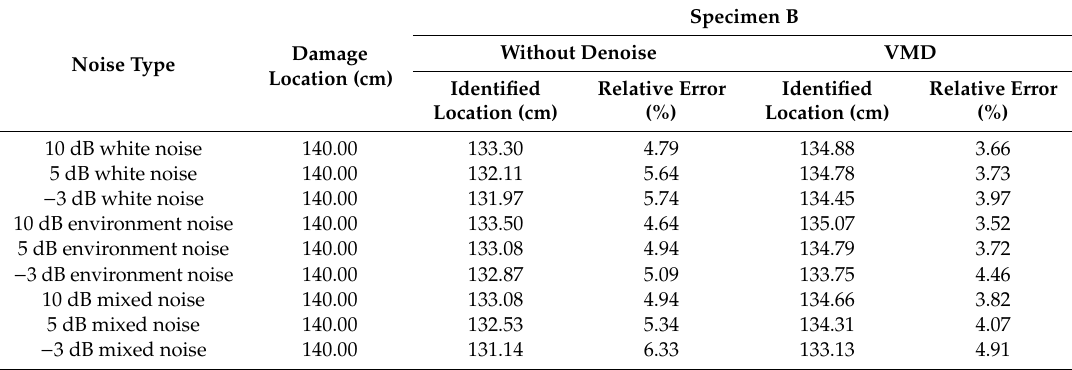
Table 4. Statistics of damage location results of specimen B before and after noise reduction using VMD in di ff erent noise environments.